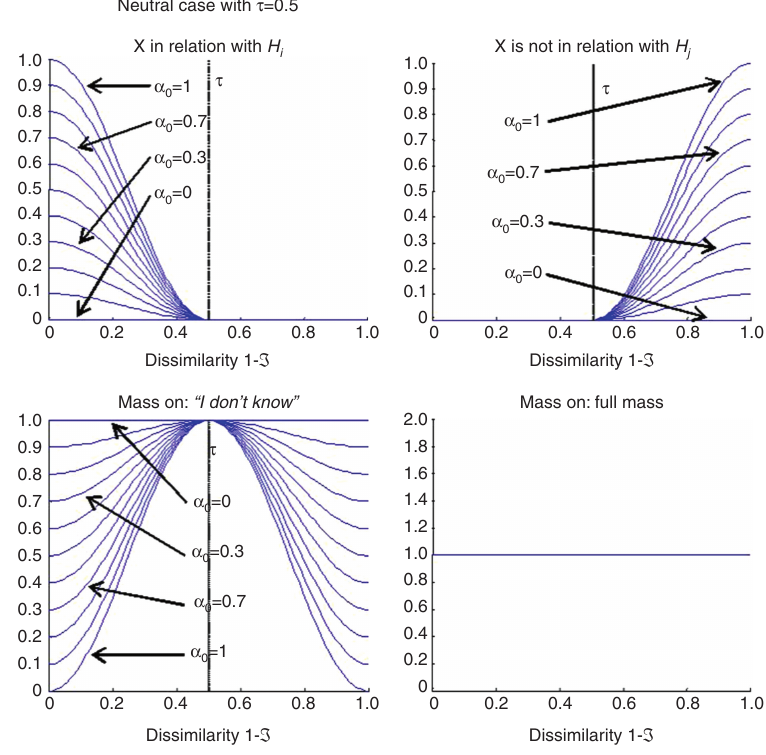
Figure 1. Functions of Mass